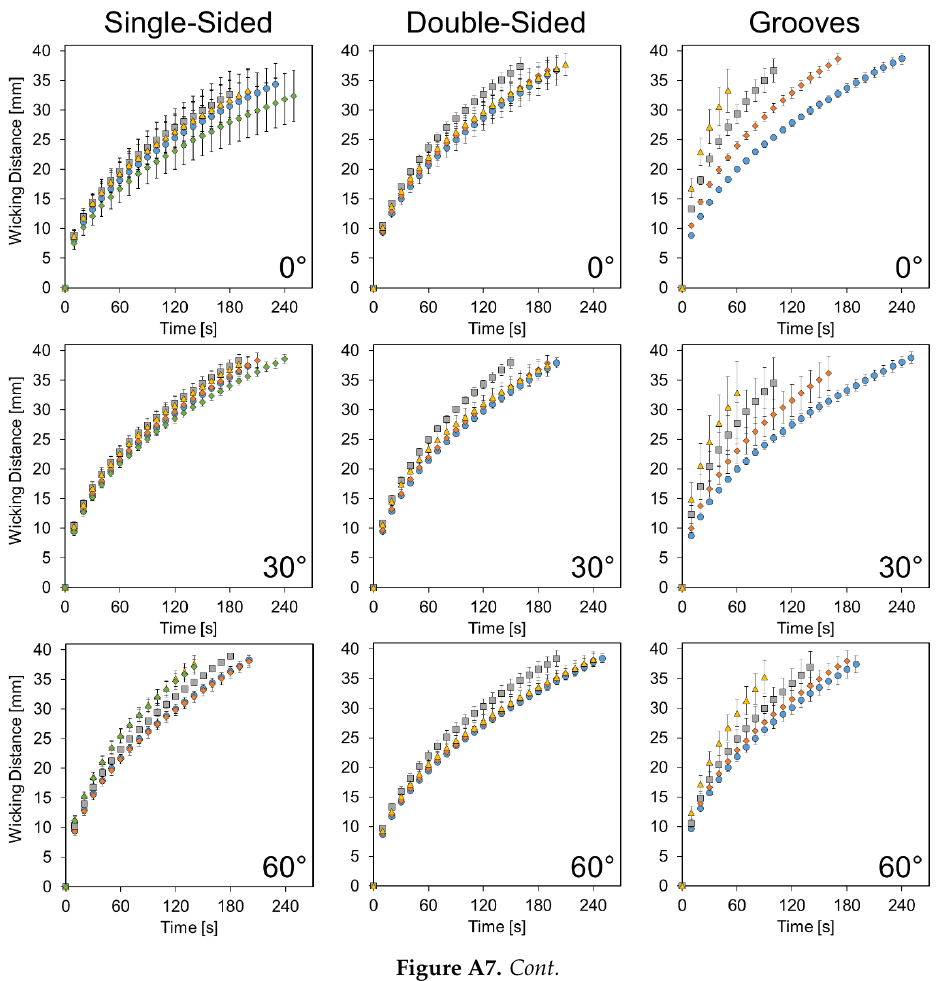
Figure A6. Depiction of why the angled wicking 0 degrees is faster than the previous data set. ( a ) Meniscuses form evenly on both sides of the paper. ( b ) External capillaries formed by the backing likely cause faster fluid delivery to the inlet of the channels. Micromachines 2020 , 11 , x